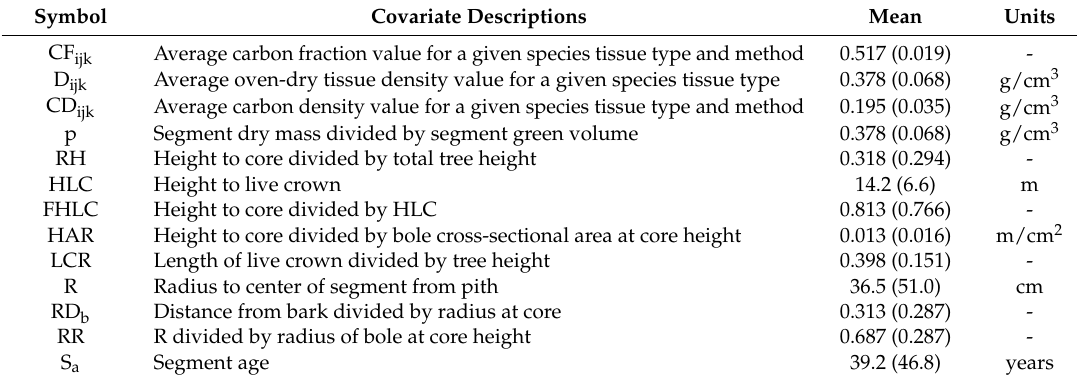
Table 4. Symbols, descriptions, and summary statistics of covariates found in final linear mixed effects (LME) models. Mean values are followed by corresponding standard deviations in